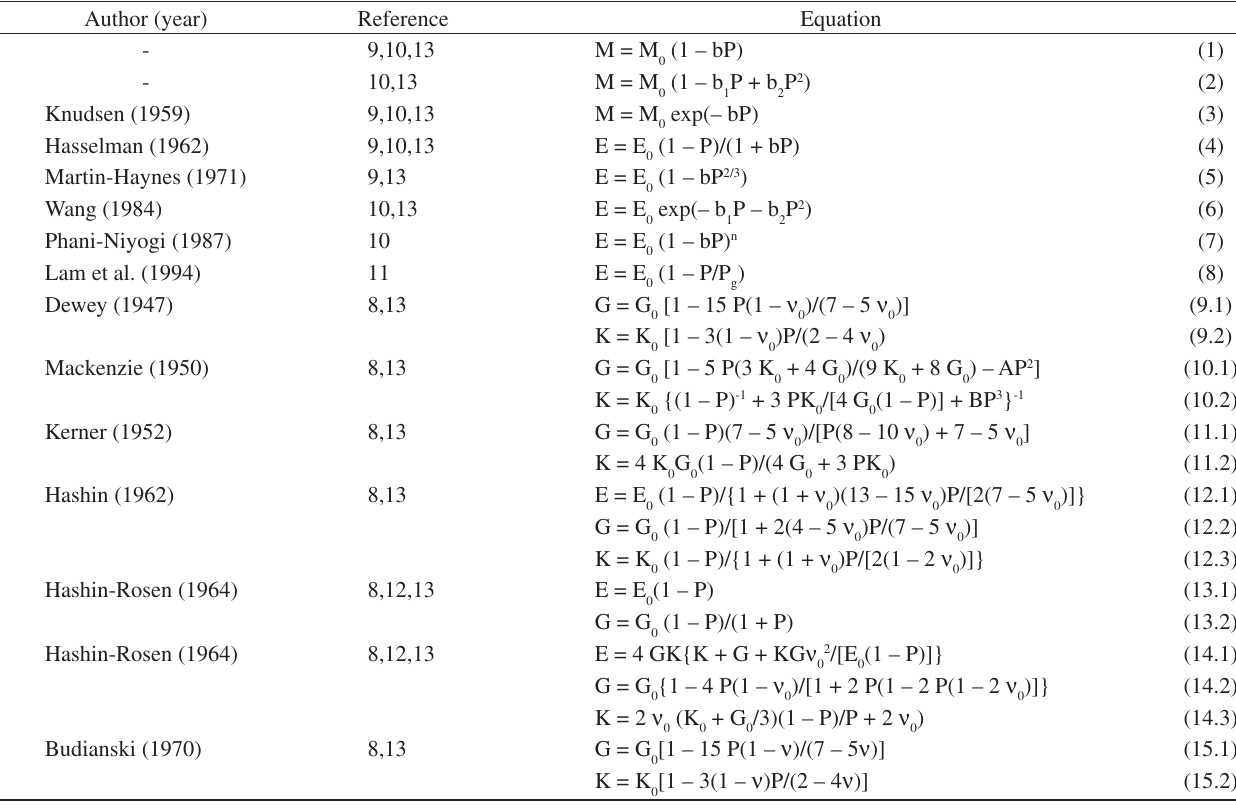
Table 1. Semi-analytical (1 to 8) and analytical (9 to 15) equations for elastic constants as a function of volume fraction porosity P 8-13 . M is an elastic property and E, G, K, and ν are Young’s, shear, and bulk modulus, and Poisson’s ratio, respectively. The subscripts 0 and g indicate the property of the material without pore and green body, respectively. The values of b, b , b , and n of Equations 1 to 7 are determined by fitting to the experimental results. 1 2 Author